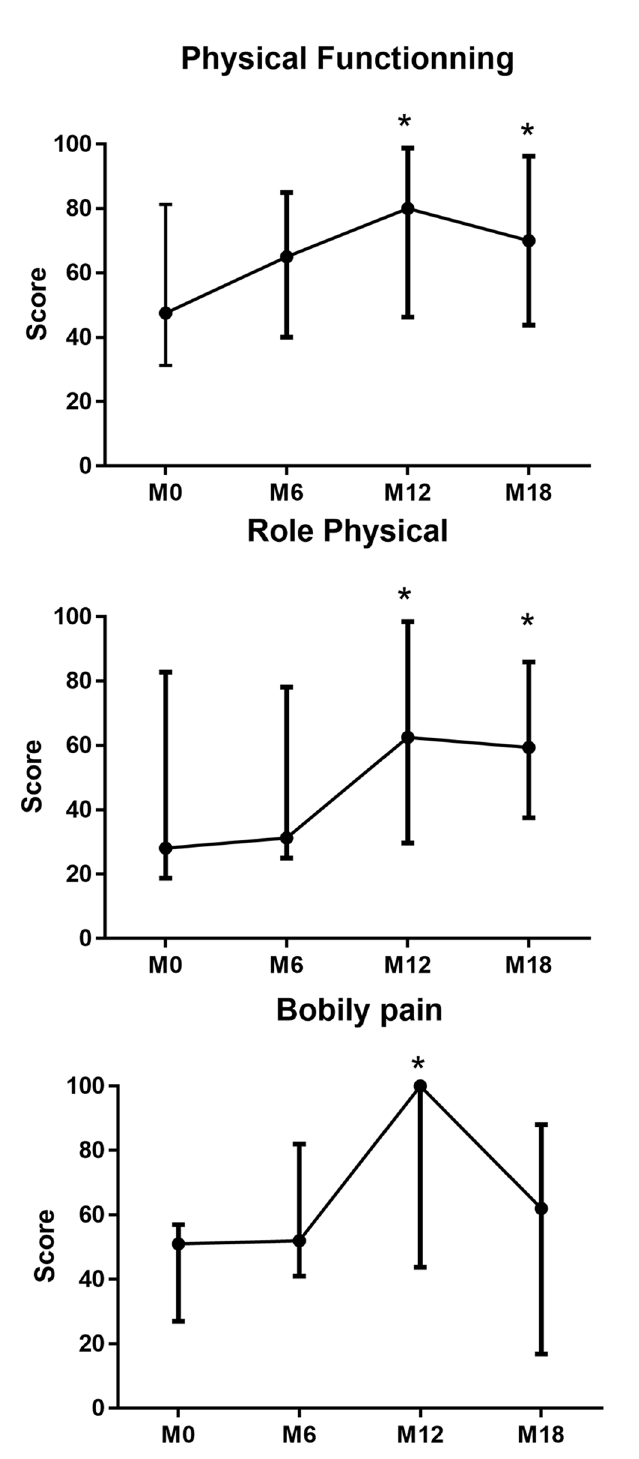
Fig 5. SF-36 scores measuring parameters of mobility. For each score (ranging from 0 to 100) the mean values ( ± SD) are represented at different time points: baseline (M0); months 6, 12 and 18 after rituximab infusion (M6, M12 and M18). The asterisk represents a significant increase (more than 10 points) compared with